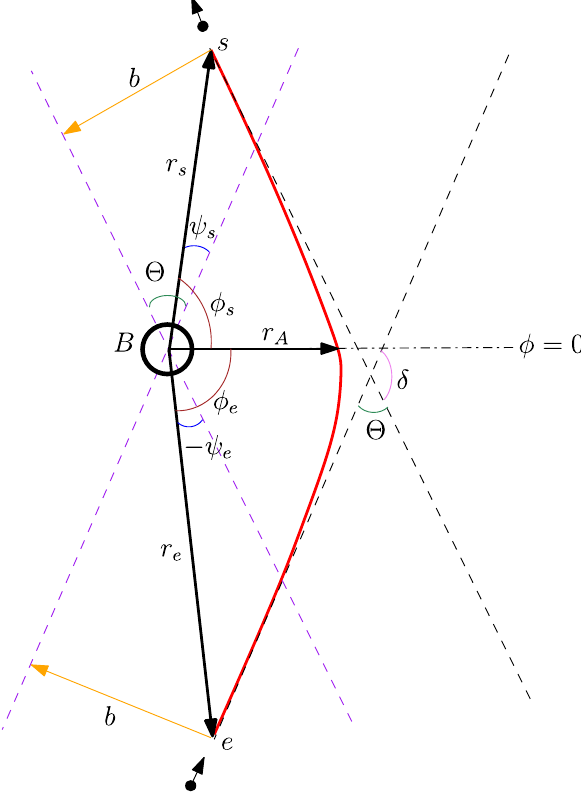
Fig. 4 Aschematicillustrationofthescatteringphenomena.Theshort- est distance to the black hole B , has been taken to be r A , lying on the φ = 0 line. The incident and the scattered particles are located respec- tively at e ( r e ,φ e , b ) and s ( r s ,φ s , b )